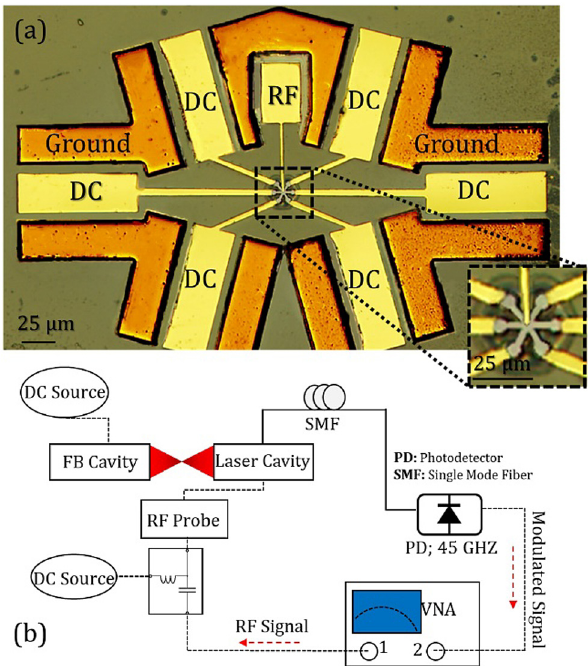
Figure 3: (a) The top-view false optical microscopic image of the fabricated multiple transverse-coupled-cavity vertical-cavity surface-emitting lasers (MTCC VCSEL) with aperture size of 3.5 × 3.5 µm 2 for inner cavity and six identical feedback, each with a length of 12 µm. With an aim to achieve high-power, single-mode operation, the Vernier effect in lateral integration in a VCSEL can be utilized to form a larger aperture size and hence, more gain medium [28, 29], and (b) our calibrated 45 GHz small-signal measurement